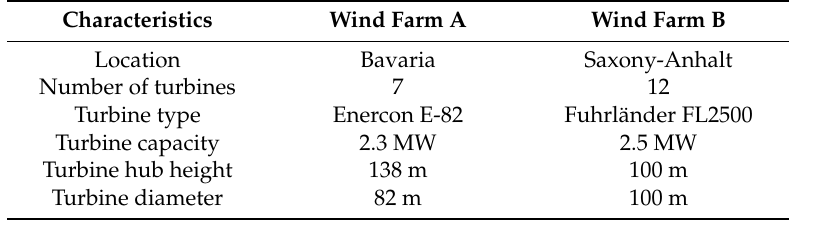
Table 1. Details on wind farms A and B.